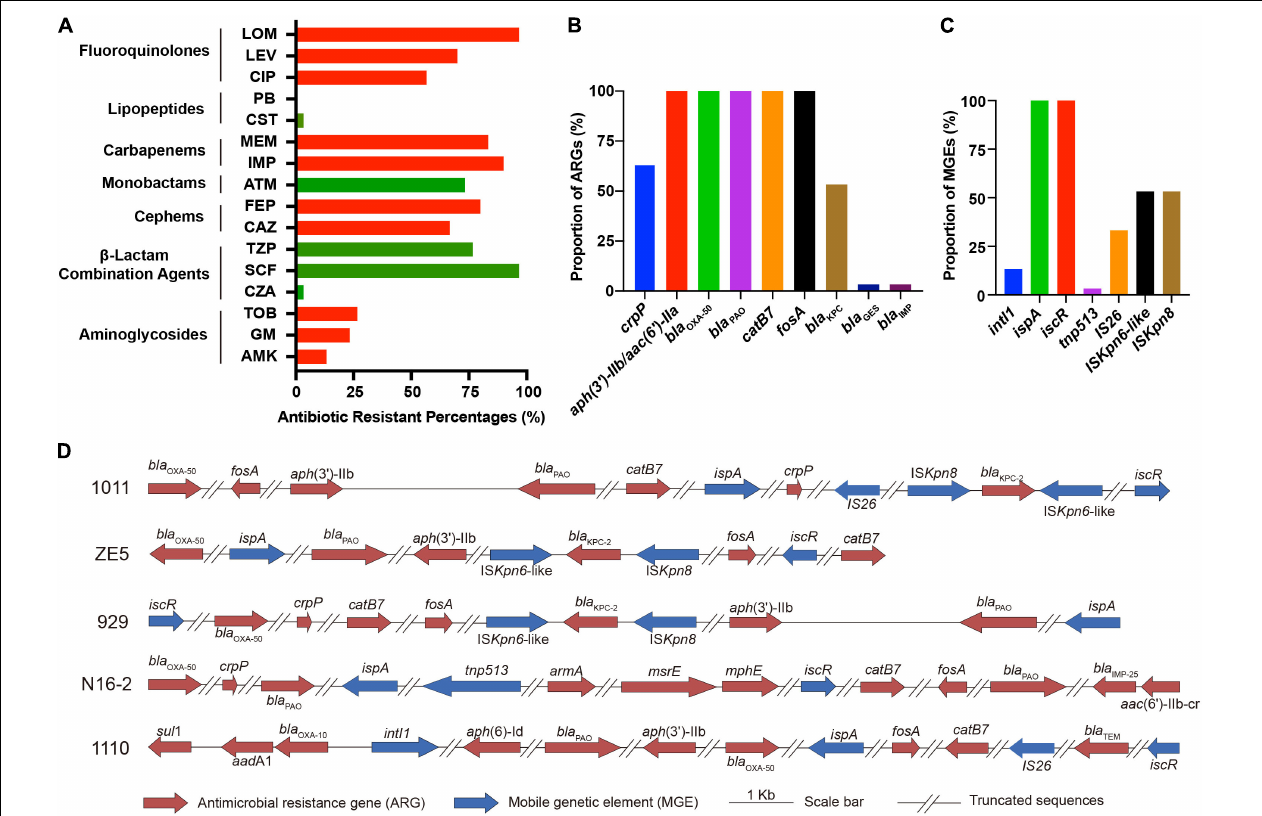
FIGURE 1 | Phenotypical and genetic profiles of antimicrobial resistance in P. aeruginosa isolates. (A) Antibiotic resistance profiles. Proportion of antimicrobial resistance genes (ARGs) (B) and mobile genetic elements (MGEs) (C) in the isolates. (D) Schematic diagram of representative ARGs and MGEs in five isolates. The bla KPC − 2 genes in P. aeruginosa 1011, ZE5, and 929 are surrounded by IS Kpn6 -like, IS Kpn8 , and other MGEs ( ispA , iscR ). P. aeruginosa N16-2 harbors MGEs ispA , tnp513 ; and P. aeruginosa 1110 harbors intl1 , IS 26 , iscR . All strains share similar patterns.